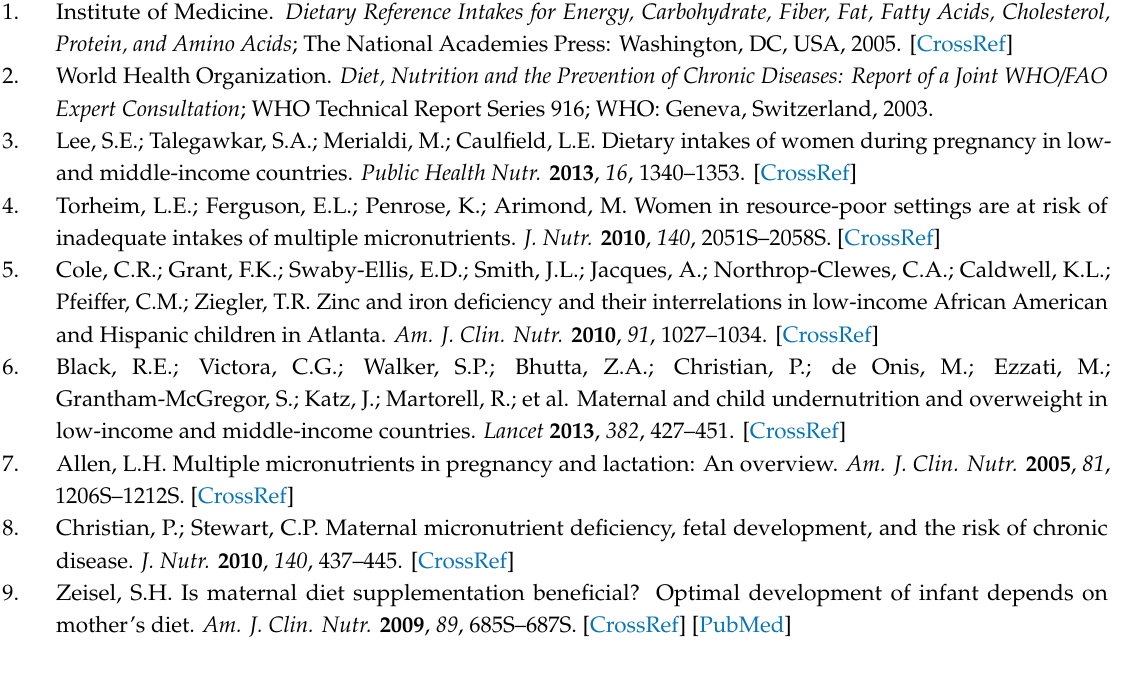
Table S1: Multivariable prediction models of biomarker trajectories over the course of pregnancy: sensitivity analysis including only those women with at least data on the baseline and late pregnancy study